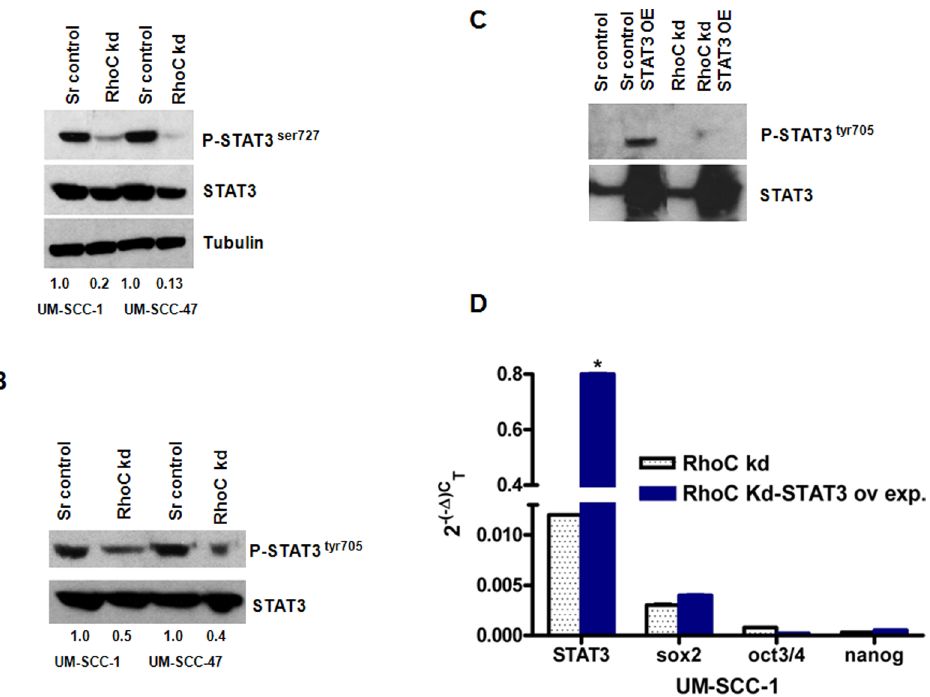
Figure 5. Expression of phospho STAT3 in scrambled control and RhoC knockdown HNSCC cell lines. (A and B) Western blot analysis showing the phosphorylation of STAT3 ser727 and STAT3 tyr705 in the scrambled controls and the RhoC knockdown UM-SCC-1 and -47 respectively. Normalized value with respect to total STAT3 is given as the numerical values. Remarkable decreases in the phosphorylation of STAT3 were seen in the RhoC knock-down UM-SCC-1 and -47 cell lines respectively. (C) Protein analysis shows the p-STAT3 tyr705 in the ectopically overexpressed (OE) scrambled control and the RhoC knockdown UM-SCC-1. Phosphorylated form was detected only in the scrambled control when STAT3 was over expressed. A thick band of total STAT3 can be seen in the lower panel, confirming the successful transfection of STAT3 in these clones. (D) Real time RT-PCR showing the expression of STAT3, sox2, oct3/4 and nanog before and after the STAT3 over expression in the RhoC knockdown clone. The mRNA expression of STAT3 was dramatically high after it’s over expression, while no significant change in the expression was observed in sox2, oct3/ 4 and nanog in the RhoC knockdown clone.